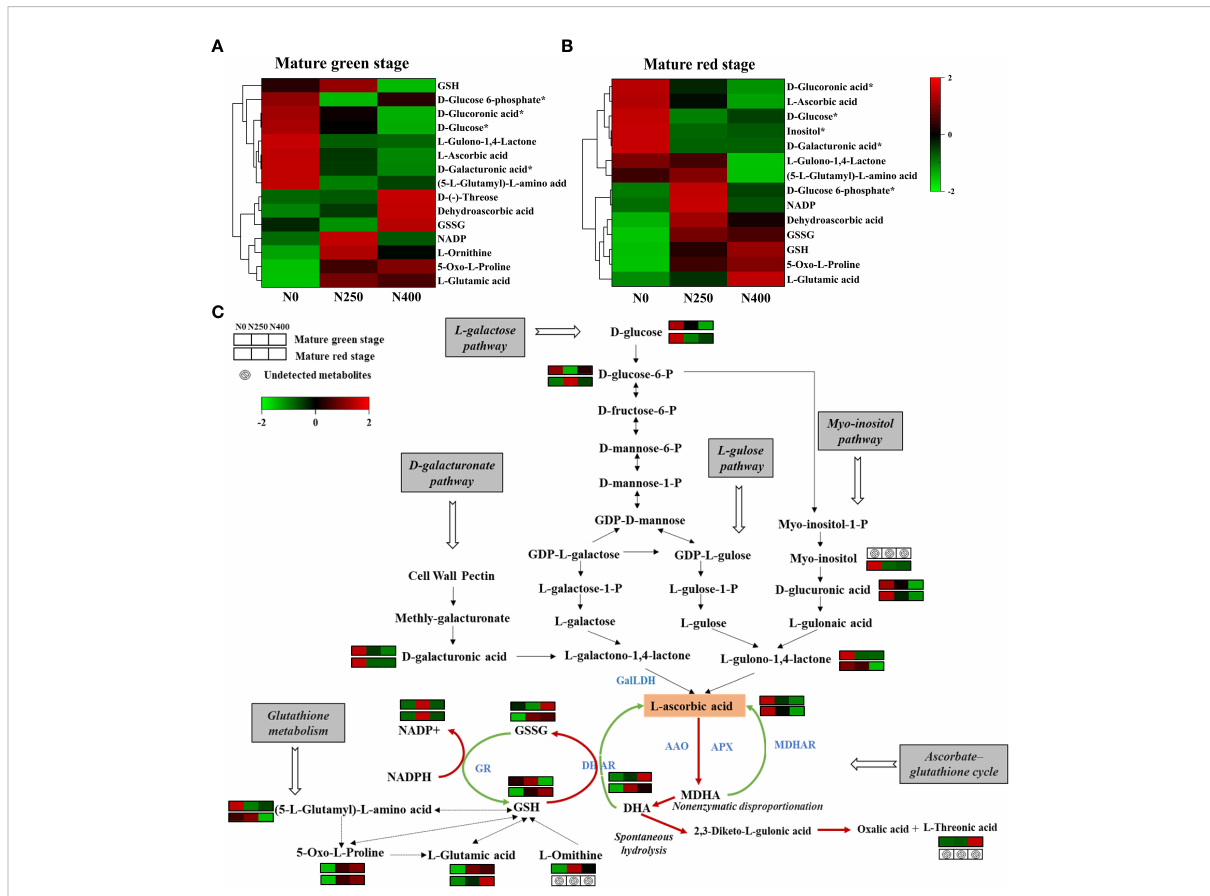
FIGURE 4 Cluster heat map showing the average accumulated metabolites (n=4) involved in AsA biosynthesis and regeneration in the pericarp of pepper fruits at mature green (A) and red (B) stage, and changes in metabolic pathways of AsA biosynthetic, AsA-GSH cycle and glutathione metabolism (C) as affected by N application. Relative abundance of metabolite (Z scores standardize to N (0, 1)) is shown on a red (high) to green (low) scale. The green line represents reduction reaction and the red line represents oxidation reaction in the AsA-GSH cycle,